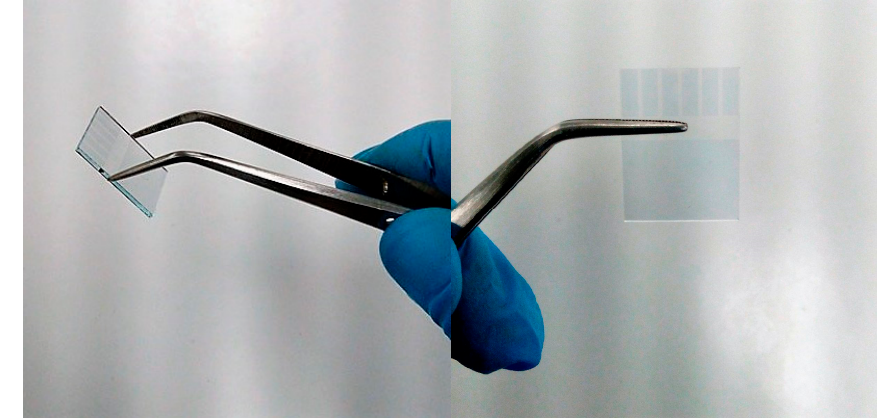
Figure 3. The correct handling of the glass substrates with tweezers.